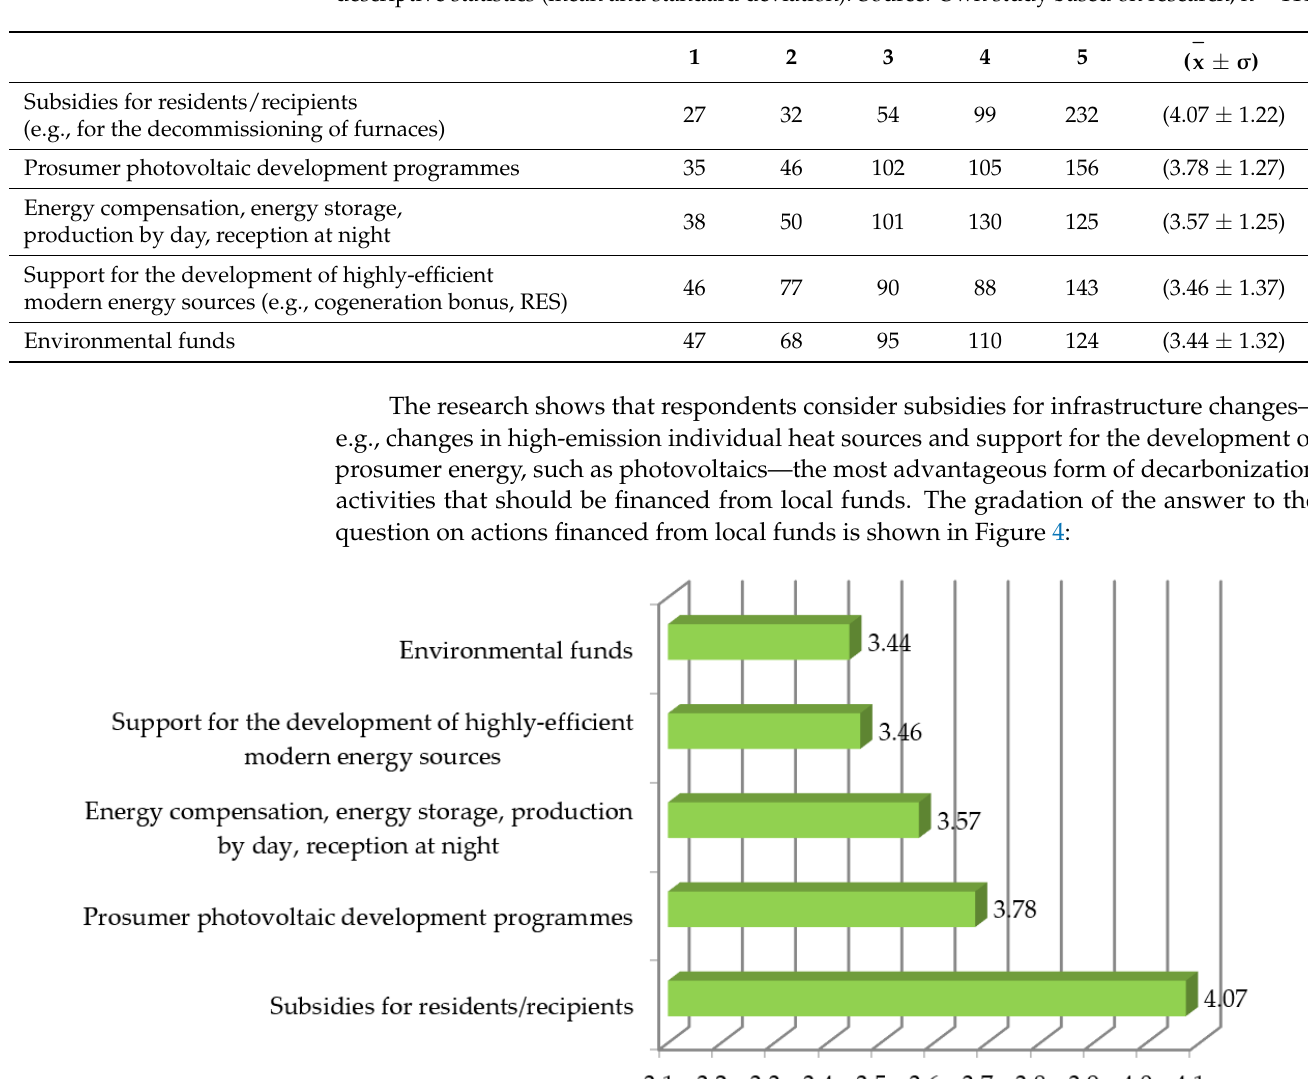
Table 4. Evaluation of decarbonization activities to be financed from local funds (counts) and basic descriptive statistics (mean and standard deviation). Source: Own study based on research, n = 444.